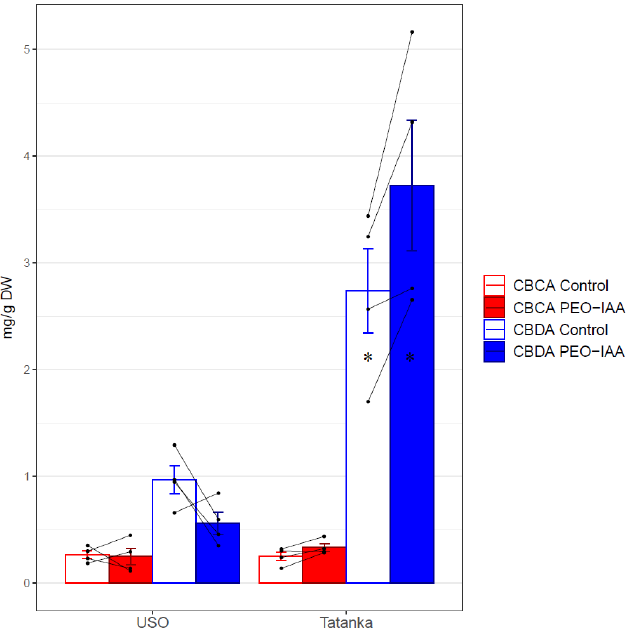
Figure 5. Bar plots show mean values and standard errors of the given concentration for both cultivars ‘USO-31’ and ‘Tatanka Pure CBD’. The points represent the concrete values. The matching samples are connected by lines. Significant differences in the concentrations of CBDA are represented by asterisks ( p ≤ 0.05 “ * ”). Table 3. Results from the t -test applied on RC in both cultivars. The p -value that denotes the statis- tical significance is in bold.